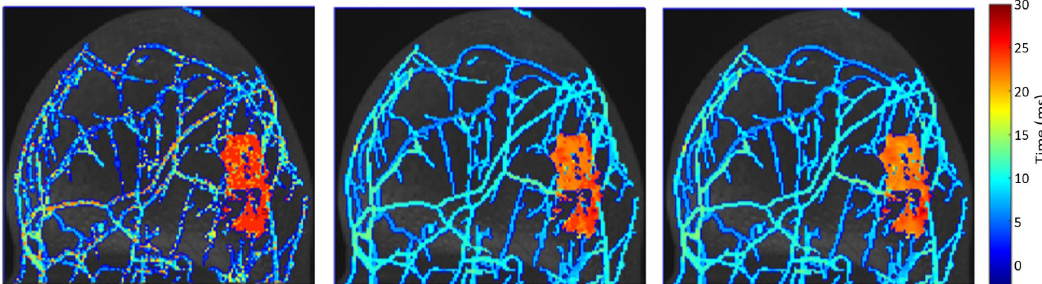
Fig 6. Bolus arrival time computed from the case 4 image set. From left to right: IFFT reconstruction, ECA reconstruction, and ground truth. Times shown on the color bar are measured in seconds.